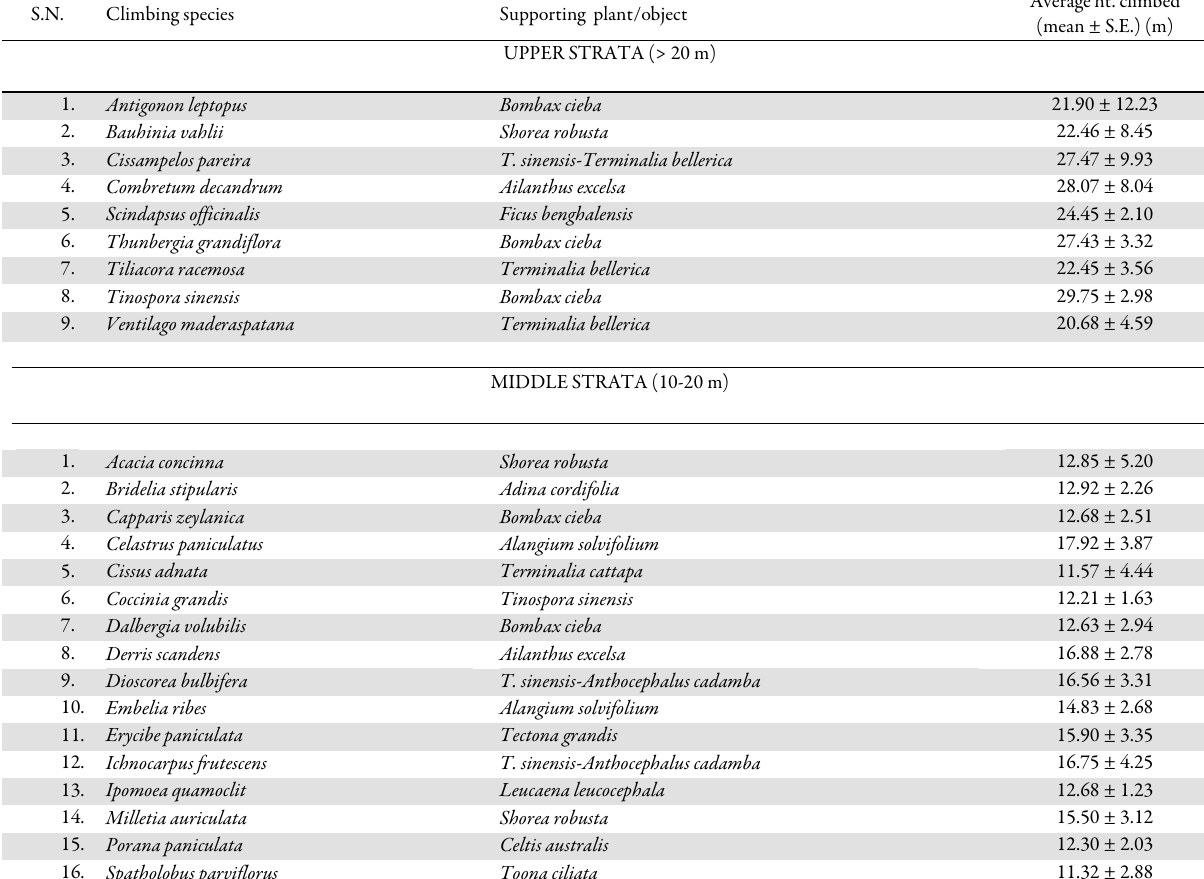
Table 2. The height (ht) climbed by various climbers, grouped within upper strata (> 20 m), middle strata (10-20 m) and lower strata (< 10 m)